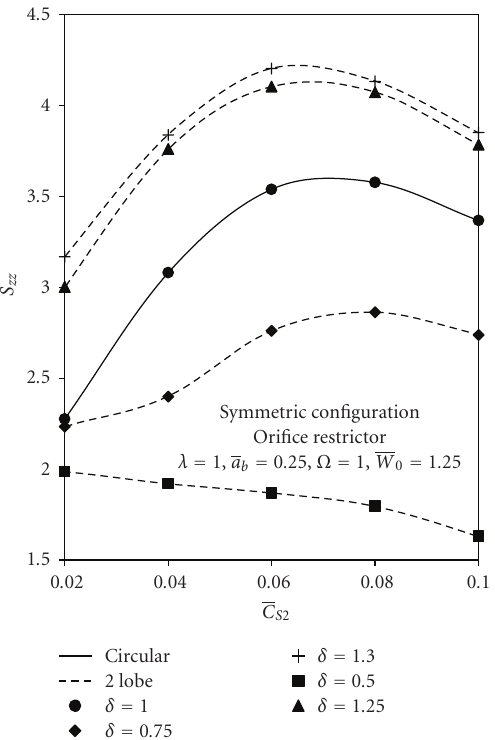
Figure 8: Variation of direct sti ff ness ( S zz